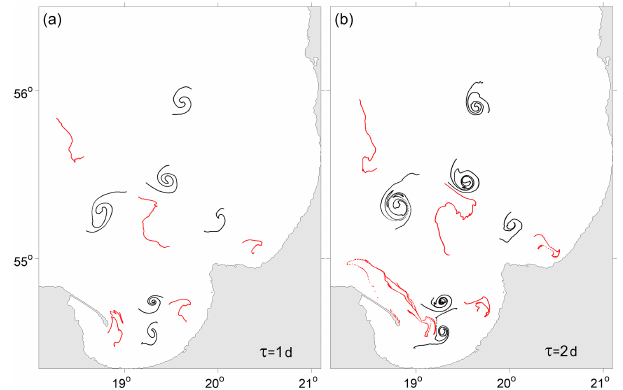
Figure 7. Patterns formed on 3 July 2015 from zonally elongated linear features passing through the centers of the simulated subme- soscale cyclonic (black curves) and anticyclonic (red curves) eddies after (a) 1d and (b) 2d of advection. The linear features included a large number (2000) of synthetic floating particles deployed 1d (a) and 2d (b) before 3 July 2015, 12:00UTC.